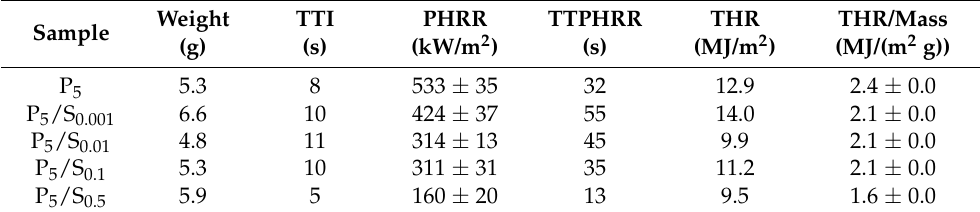
Table 4. Cone Calorimetry Data for PVA and PVA/NaOH